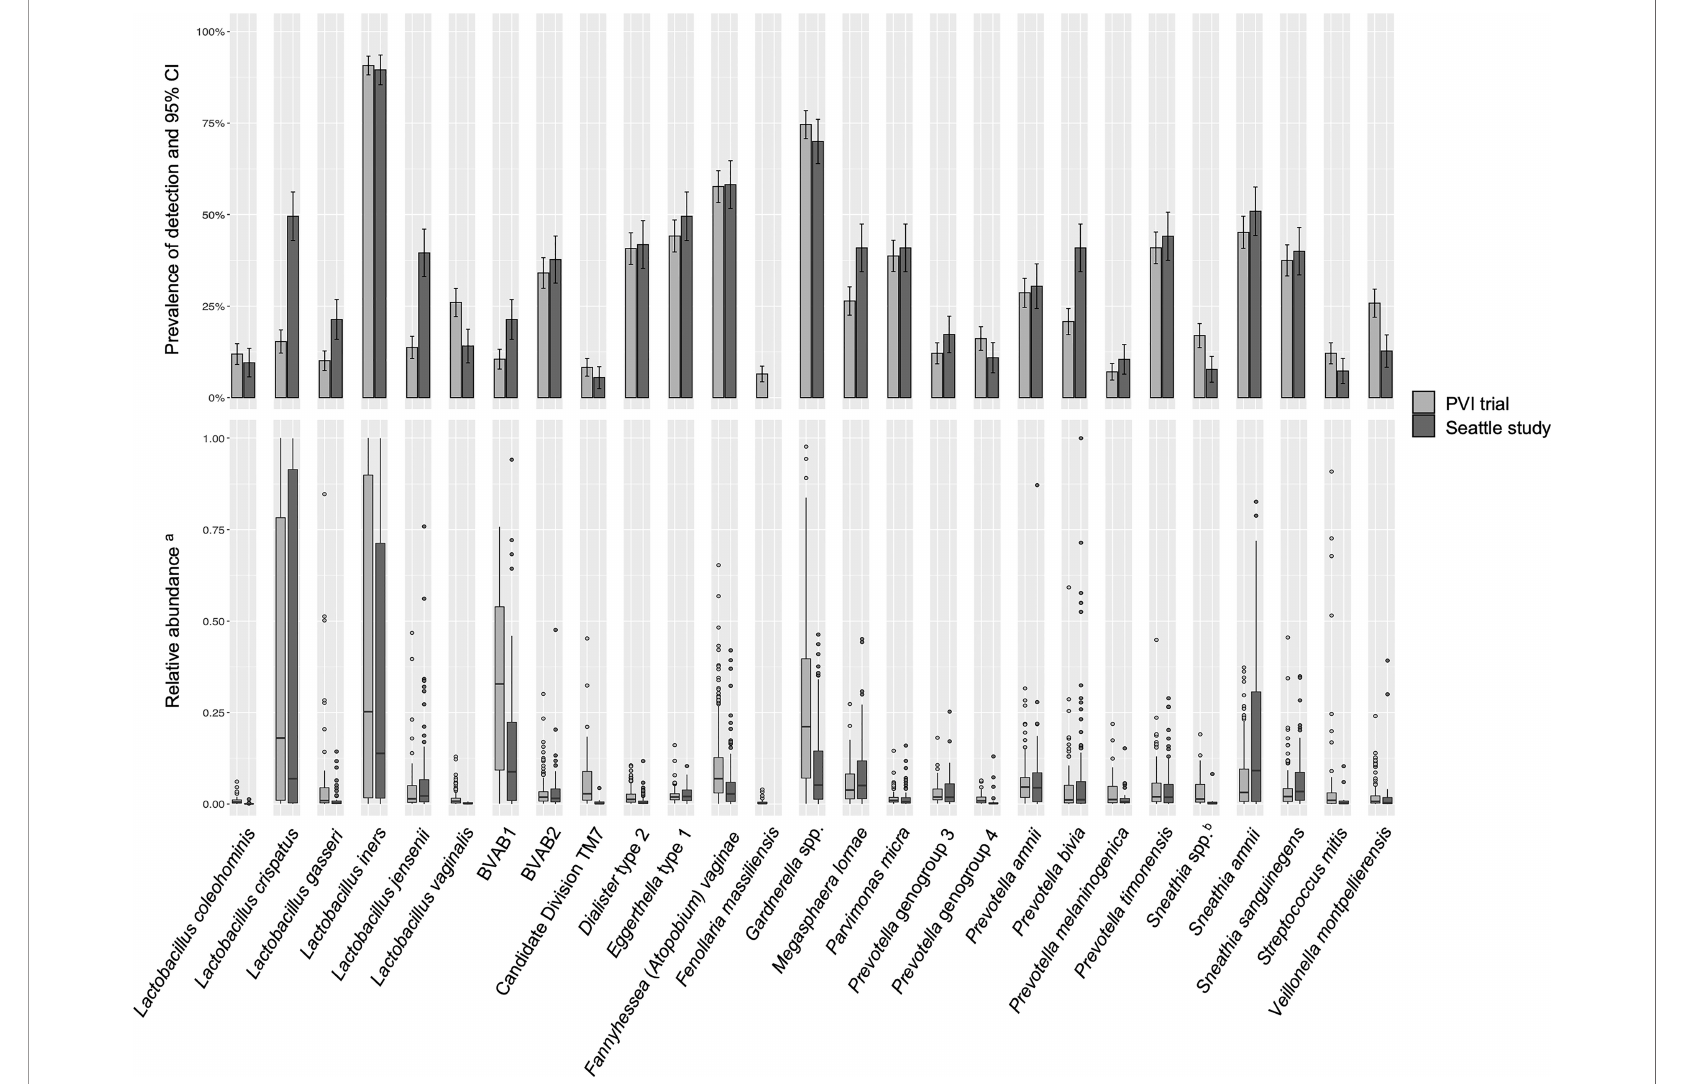
FIGURE 1 | Detection and relative abundance of bacteria included in modeling analysis. All bacteria identi fi ed by ANCOM as signi fi cantly differentially abundant between samples with and without an Amsel criterion in either study population were included as exposures in modeling analysis and are presented in this fi gure. a Relative abundances are presented for samples in which a given taxon was detected. b Sneathia spp. includes those not classi fi ed at the species level as S . amnii or S . sanguinegens , but closely related to these two species. Sequences are not suf fi ciently different at the V3-V4 region of the 16S rRNA gene to classify at the species level, hence classi fi ed at the genus level. PVI, Preventing Vaginal Infections; CI, con fi dence interval; BVAB, bacterial vaginosis associated bacterium; ANCOM, analysis of composition of